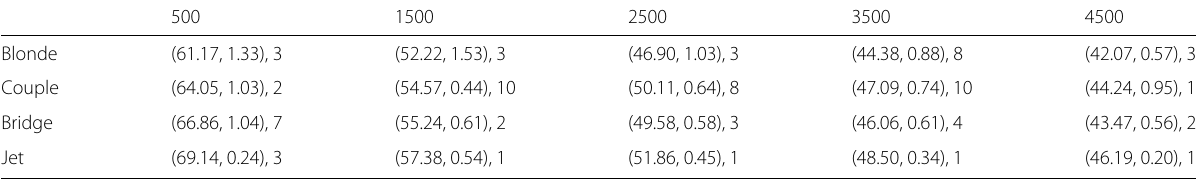
Table 4 Mean and standard deviation of the PSNR values with different context windows, and optimal